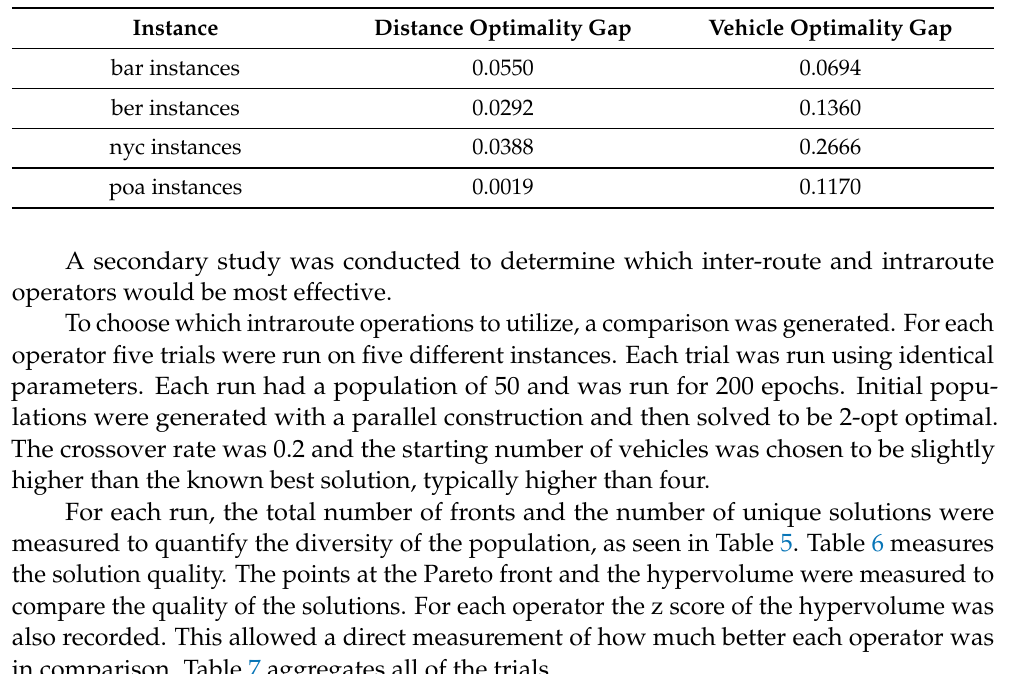
Table 4. Summary on Sulzbach Sartori and Buriol’s benchmark.